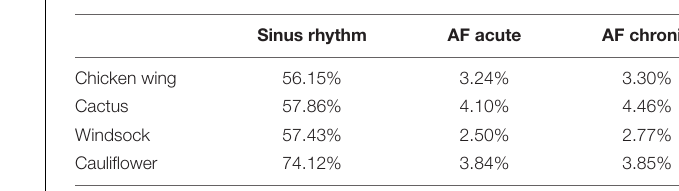
TABLE 1 | Percentage volume change simulated for all models and all operating conditions.